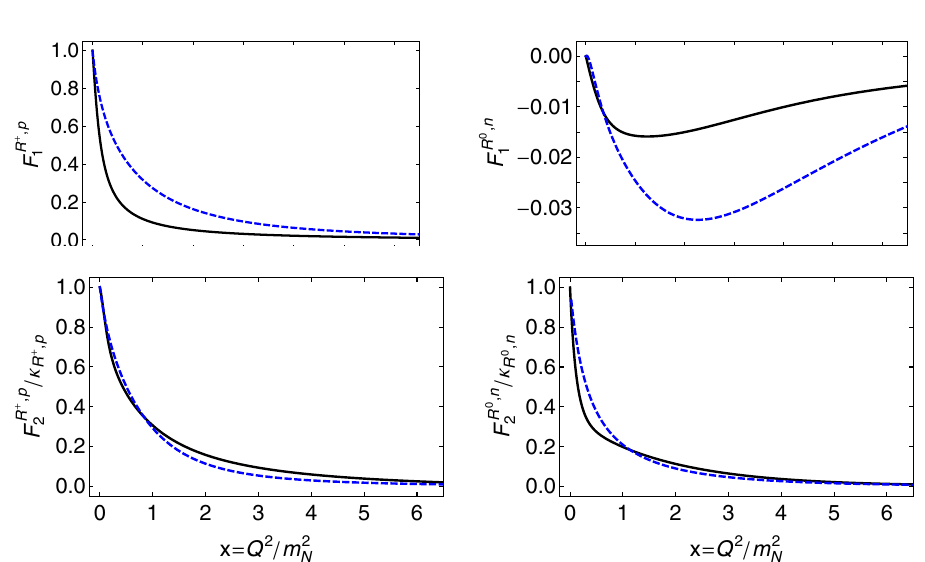
Figure 3. Solid (black) curves – Dirac (upper panels) and Pauli (lower) elastic electromagnetic form factors associated with the dressed-quark cores of the charged (left) and neutral (right) Roper systems. Dashed (blue) curves – analogous results for proton and neutron. ( κ R , N = F R , N ( x = 0); x = Q 2 / m 2 , where M N = 1 . 18GeV is the nucleon’ dressed-quark core mass.) N 2